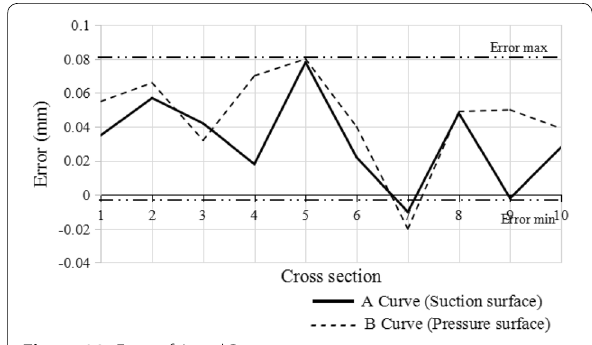
Figure 23 Error of A and B curves